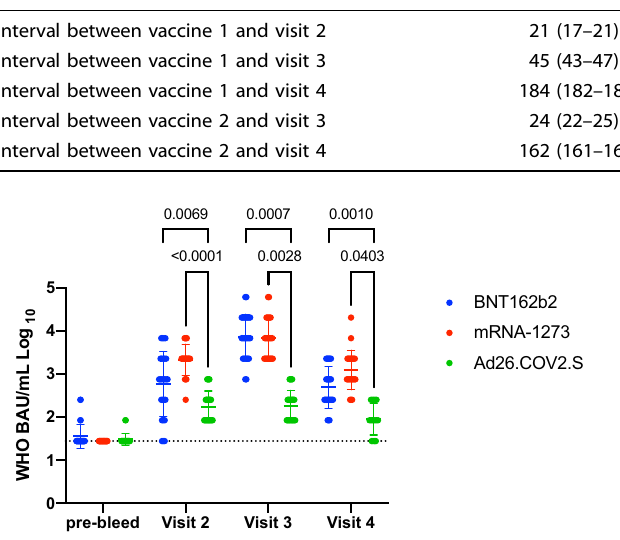
Fig. 1 RBD ELISA titers amongst vaccine recipients. Plasma from each timepoint was tested by an RBD ELISA and then converted to WHO BAU/mL. Each data point is shown, the geometric mean and geometric standard deviation are plotted. The dotted line is the limit of detection of the assay (WHO BAU/mL of 28). Statistically signi fi cant differences using a mixed effects model with the Geisser-Greenhouse correction for unequal variance and Holm- Sidak multiple comparison test are noted by the respective p